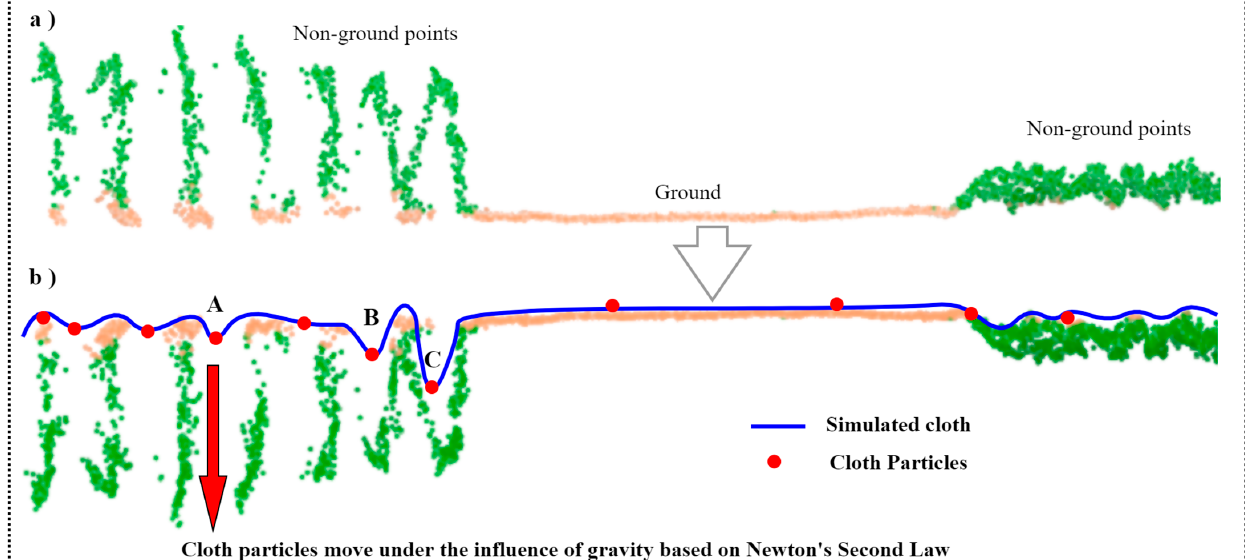
Figure 5. The CSF algorithm: ( a ) original point clouds. ( b ) Inverted point clouds with simulated cloth with cloth particles (red dots) with RI values 3 at A, 2 at B, and 1 at C, respectively.